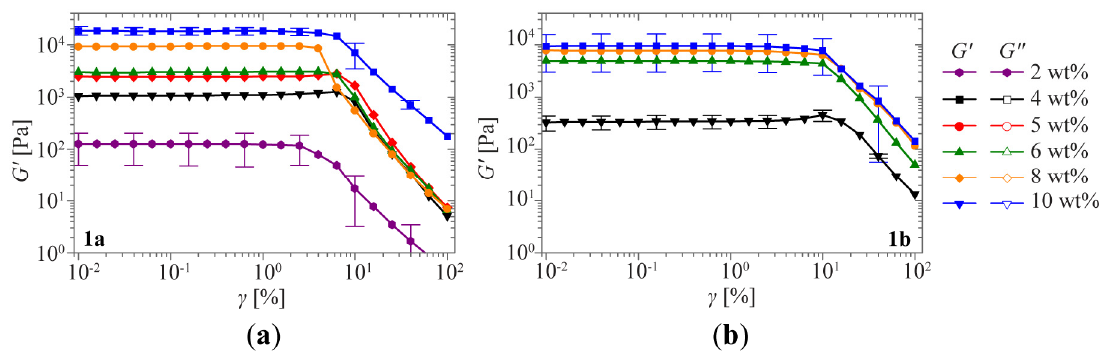
Figure 5. Oscillatory rheological measurements. Strain sweeps for 1a ( a ) and 1b ( b ) at concentrations ranging from 2 and 4 to 10 wt %. Error bars shown on the curves for the highest and lowest concentrations (at every third point) indicate a typical experimental